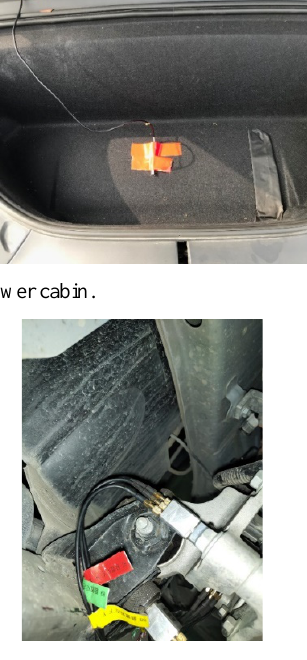
Fig. 12. Vibration acceleration sensor of upper and lower measuring points of motor mount.